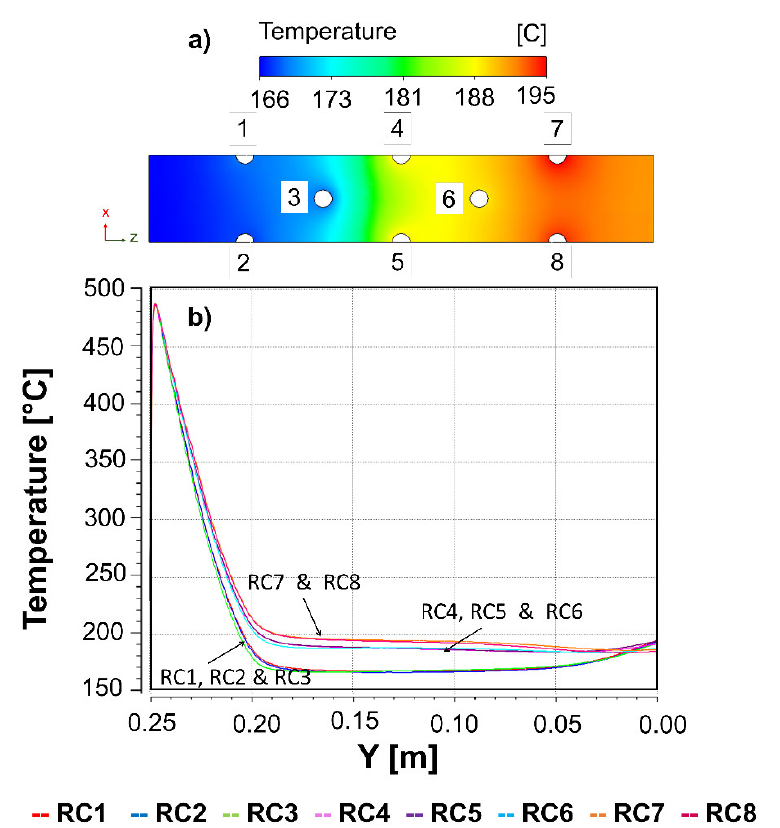
Figure 4. Temperature profiles of the ( a ) insulating material in the XZ plane performed at the middle of the reactor (125 mm); ( b ) each reactive channel along its Y height (0–250 mm). of the reactor (125 mm); ( b ) each reactive channel along its Y height (0–250